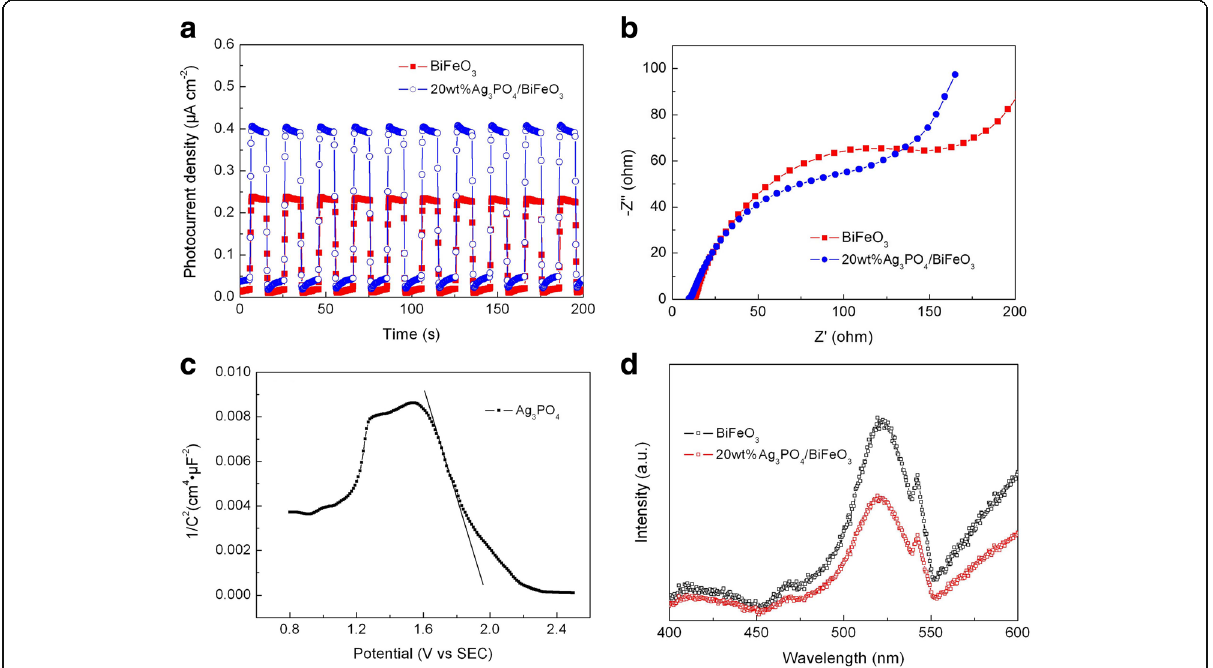
Fig. 10 a Transient photocurrent response and b EIS spectra of BiFeO 3 and 20wt%Ag 3 PO 4 /BiFeO 3 sample. c Mott-Schottky plot of Ag 3 PO 4 . d PL spectra of BiFeO 3 and 20wt%Ag 3 PO 4 /BiFeO 3